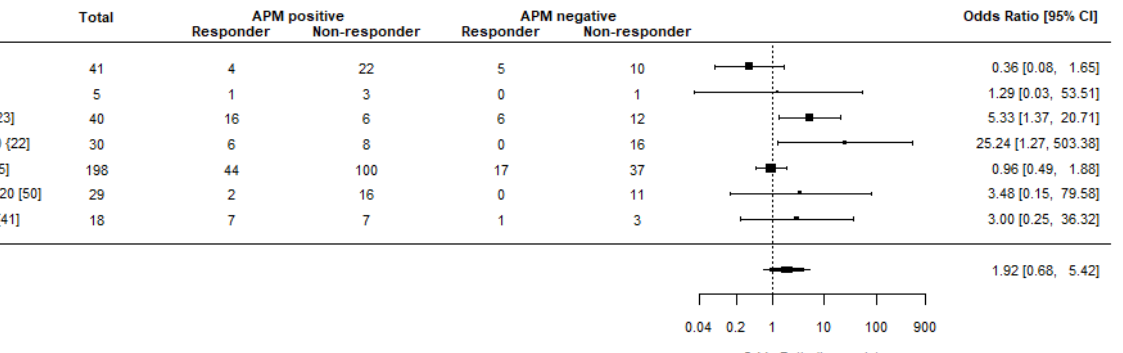
Figure 4. Meta-analyses investigating the association between normal APM (no mutations and/or normal RNA/protein expression of the relevant genes) and objective response rates from ICI treat- ment. The black box represents the point estimate for the respective study, while the vertical line is the 95% CI. Balatoni et al. [52] was re-analyzed by Ladányi et al. [22].